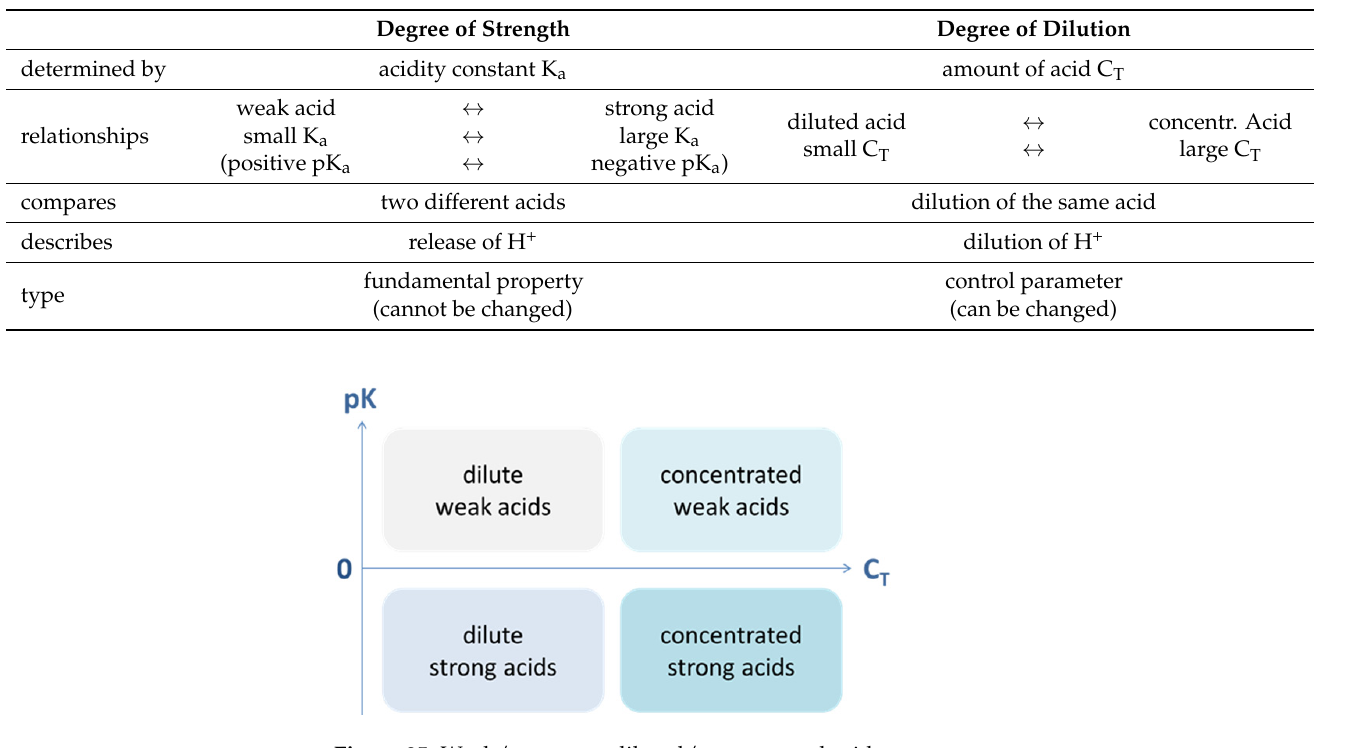
Table 6. Degree of strength vs. degree of dilution.